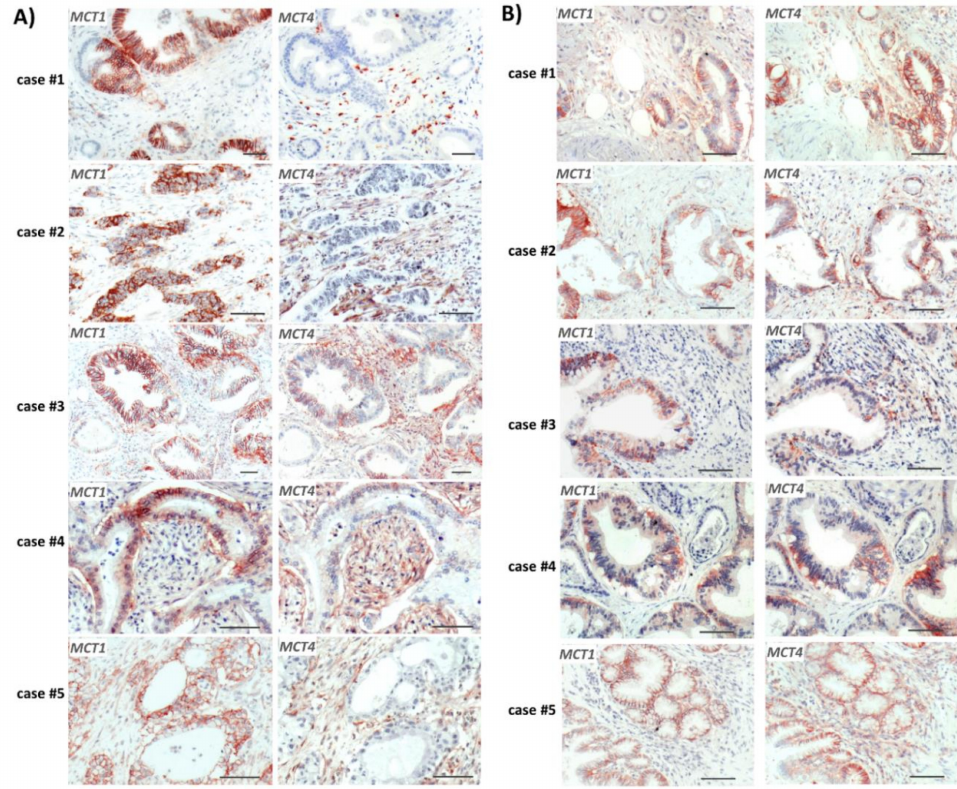
Figure 1. Reciprocal expression of monocarboxylate transporter-1 (MCT1) and -4 (MCT4) in human Pancreatic ductal adenocarcinoma (PDAC) tissues. Using antibodies directed against MCT1 and MCT4, respectively, immunohistochemical analysis was conducted with consecutive formaline-fixed para ffi n-embedded (FFPE) tumor sections from PDAC patients (all staged IIb) [33]. Tissue stainings from ( A ) five PDAC cases with MCT1 expression in cancer cells and reciprocal expression of MCT4 largely in stromal cells and ( B ) five PDAC cases with reciprocal MCT1 and MCT4 expression in cancer cells are shown (scale bar = 50 µ